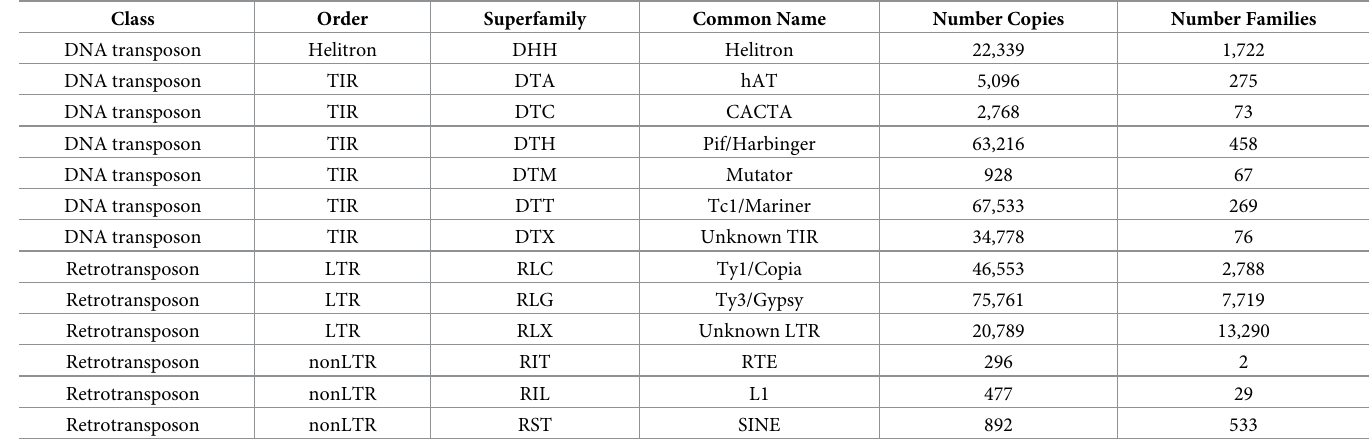
Table 1. TE superfamilies in the maize genome.